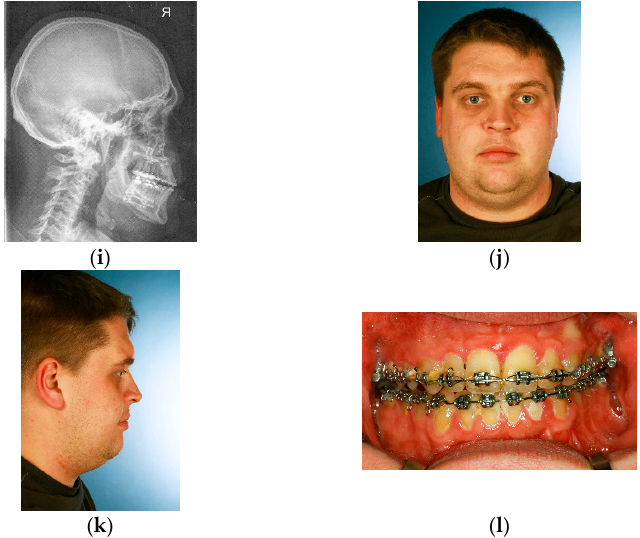
Figure 1. ( a – d ) Preoperative clinical and radiological situation in a 25 year ‐ old patient affected by hemimandibular hyperplasia; ( e ) Corresponding scintigraphy demonstrating increased tracer uptake in the right mandibular condyle; ( f ) Specimen after surgical resection of the “active condyle”; ( g , h ) Surgical management of the transverse maxillary deficiency by transpalatal distraction; ( g ) during orthodontic alignment; ( h ) palatal view after device removal; ( i – l ) Radiologic and clinical situation after combined treatment—1: simultaneous condylectomy & transpalatal distraction; 2: orthodontic alignment; 3: reorientation of the mandibulomaxillary complex by “two ‐ jaw ‐